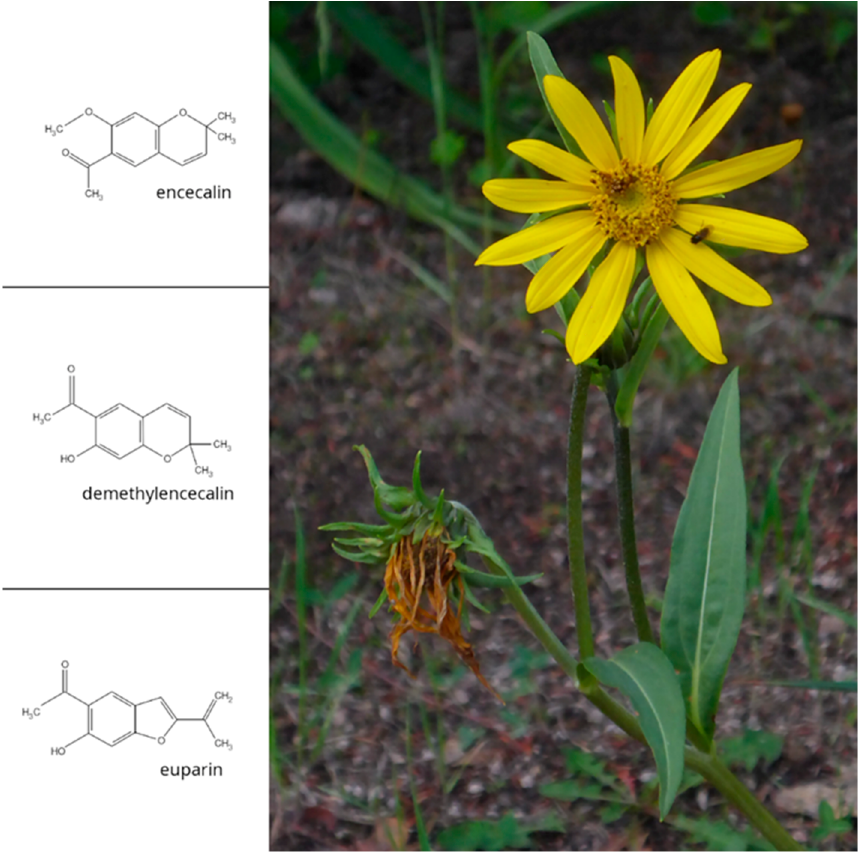
Figure 1. Helianthella quinquenervis and chemical structures of encecalin and related compounds demethylencecalin and euparin (photo of flowering plant: Bocoyna, Chihuahua; R. Bye).